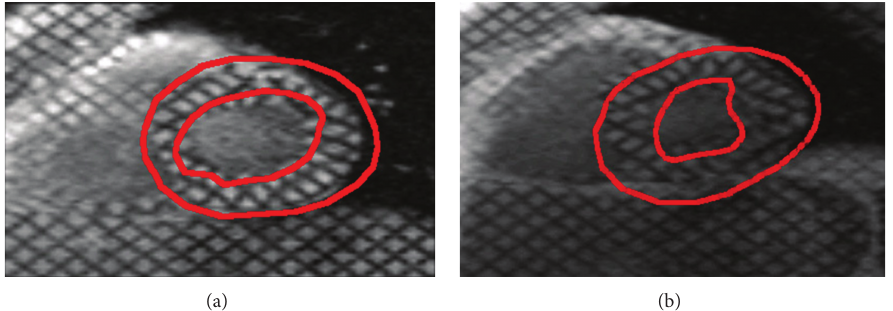
Figure 8: Illustrating misregistration of images when active contraction is not used. Heart 1 (a) shows anterior-laterial as well as septal misregistration for the epicardial surface. Heart 2 (b) shows posterior-lateral and septal misregistration for the epicardial surface.